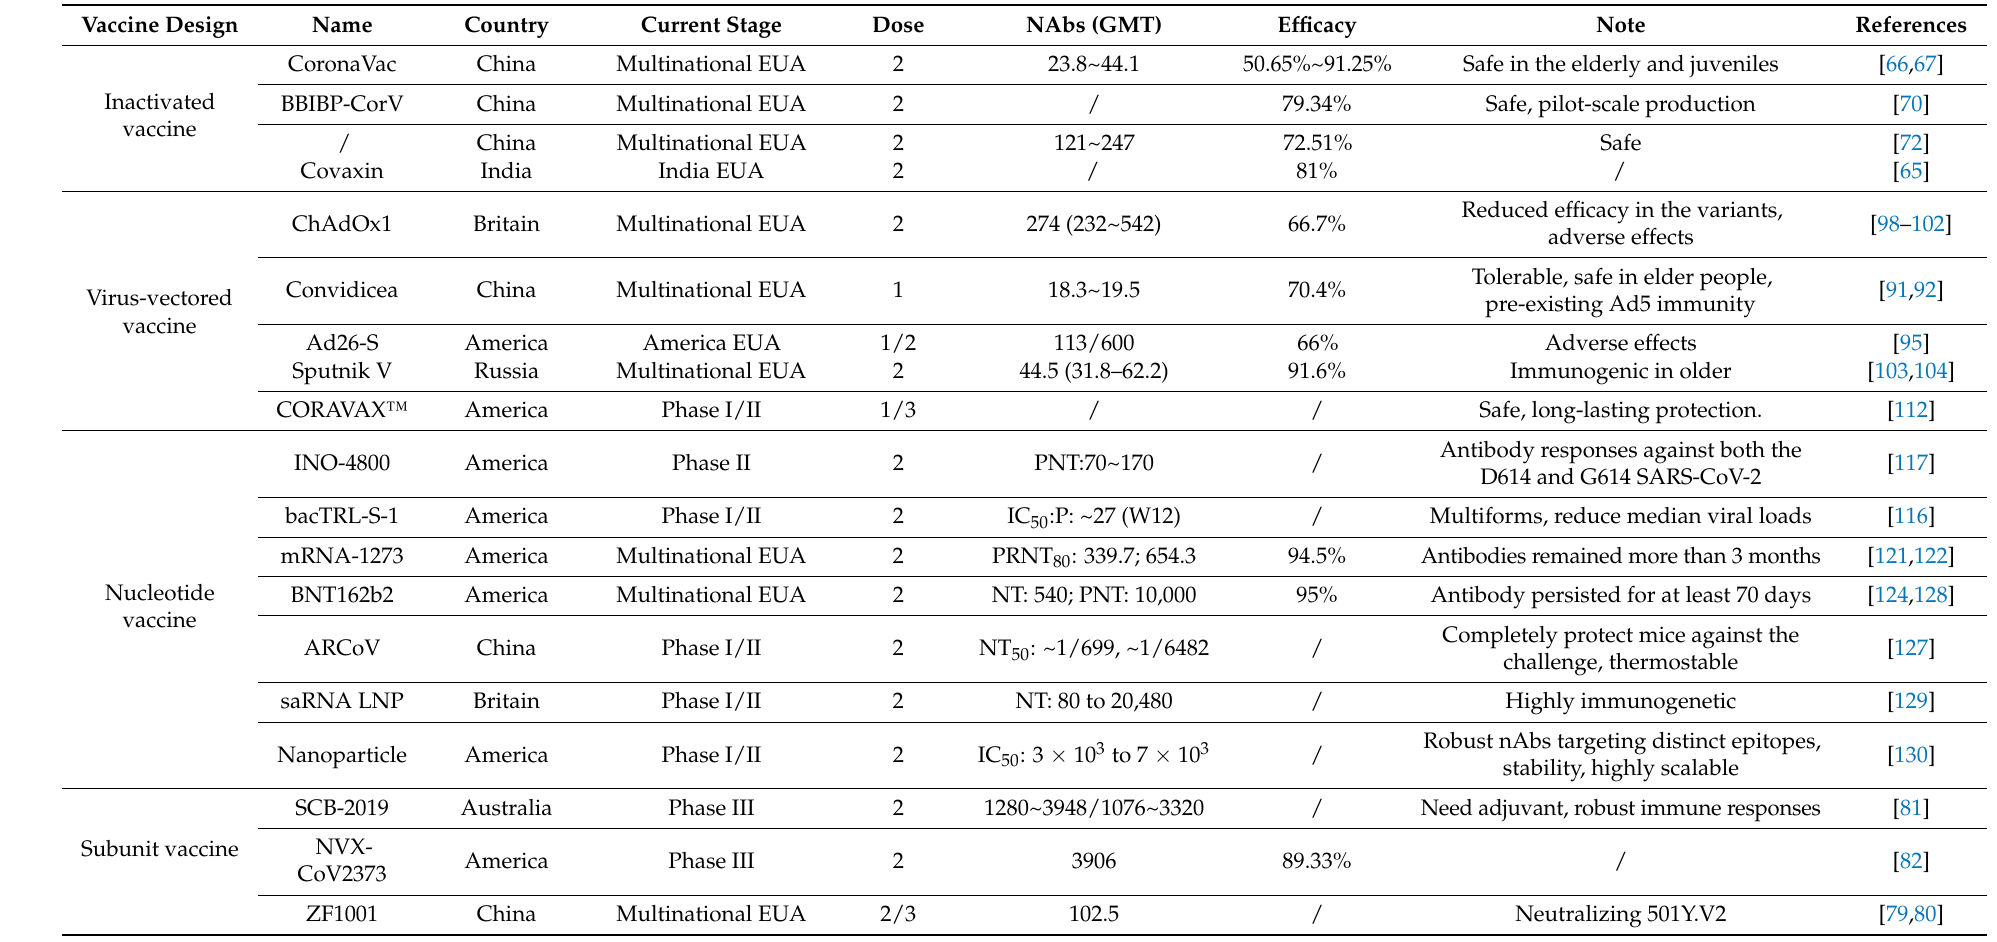
Table 2. Details of vaccines for